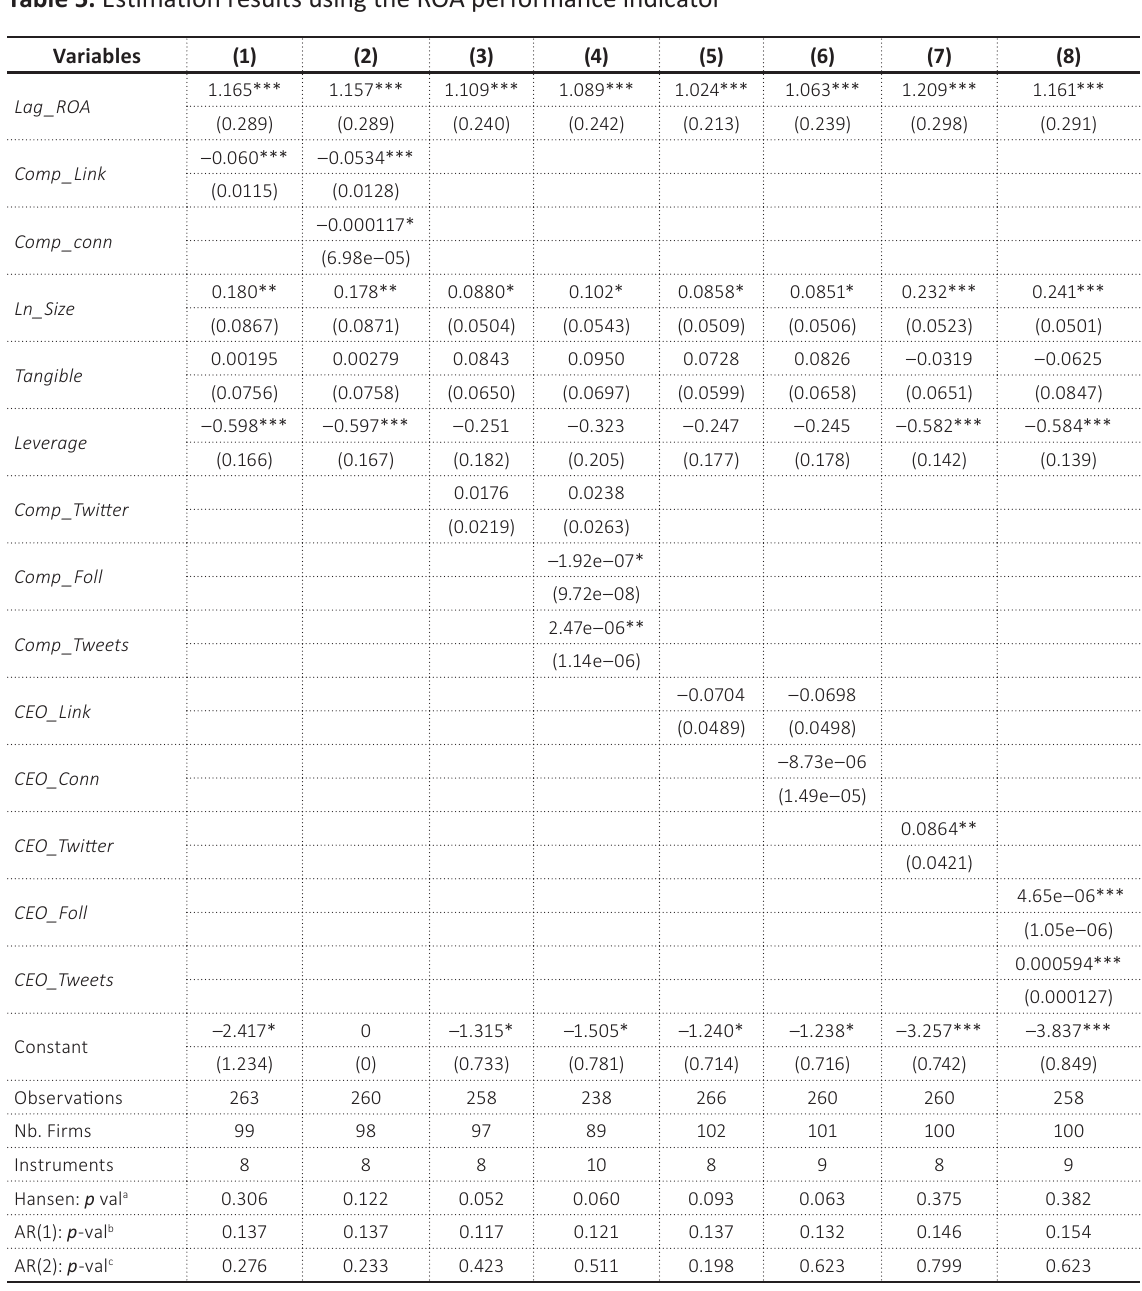
Table 5. Estimation results using the ROA performance